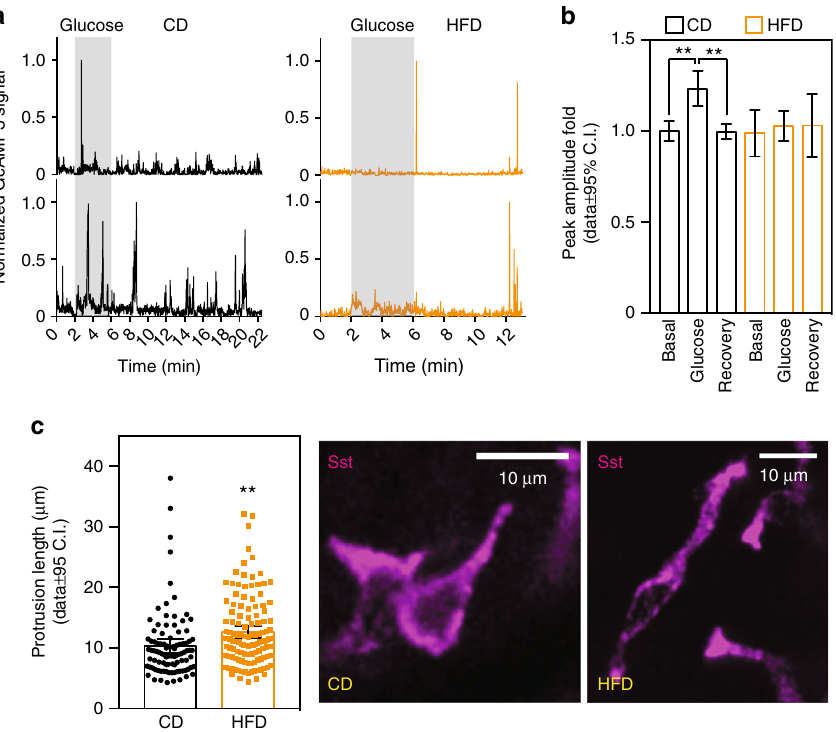
Fig. 5 Delta cell activity is impaired in prediabetes. a Representative normalized traces of GCaMP3 signals measured in vivo in delta cells from animals fed with control (CD, black lines) or HFD (orange lines). As in Fig. 1, the yellow-shaded area marks the time period used for measurements of glucose responses. b Spiking delta cell Ca 2 + peak amplitude signal during basal, glucose, or recovery time periods normalized to basal conditions in CD (basal: n = 358; glucose: n = 588; recovery: n = 1060 peaks from n = 23 cells in four islets total and one islet per animal) or HFD (basal: n = 127; glucose: n = 224; recovery: n = 353 peaks from n = 14 cells in four islets total and one islet per animal for a total of four animals) animals. Data shown as fold change from the basal state. c Physical length of the delta cell fi lopodia in its longest axis (tip to cell body) from islets in situ from CD ( n = 4 mice, 33 islets total, n = 33 delta cells) or HFD ( n = 4 mice, 42 islets total, n = 42 delta cells) animals. Right, maximum projection images of delta cells acquired with confocal microscopy in CD or HFD animals. Scale bars, a 50 μ m and (H), 10 μ m. Statistics: b data shown for false discovery rate (FDR, q < 0.005 for discovery): ** q < 0.002, p < 0.001 by OneWay Anova with a multi-comparison test using a two-stage linear step-up procedure of Benjamini, Krieger, and Yakutieli.